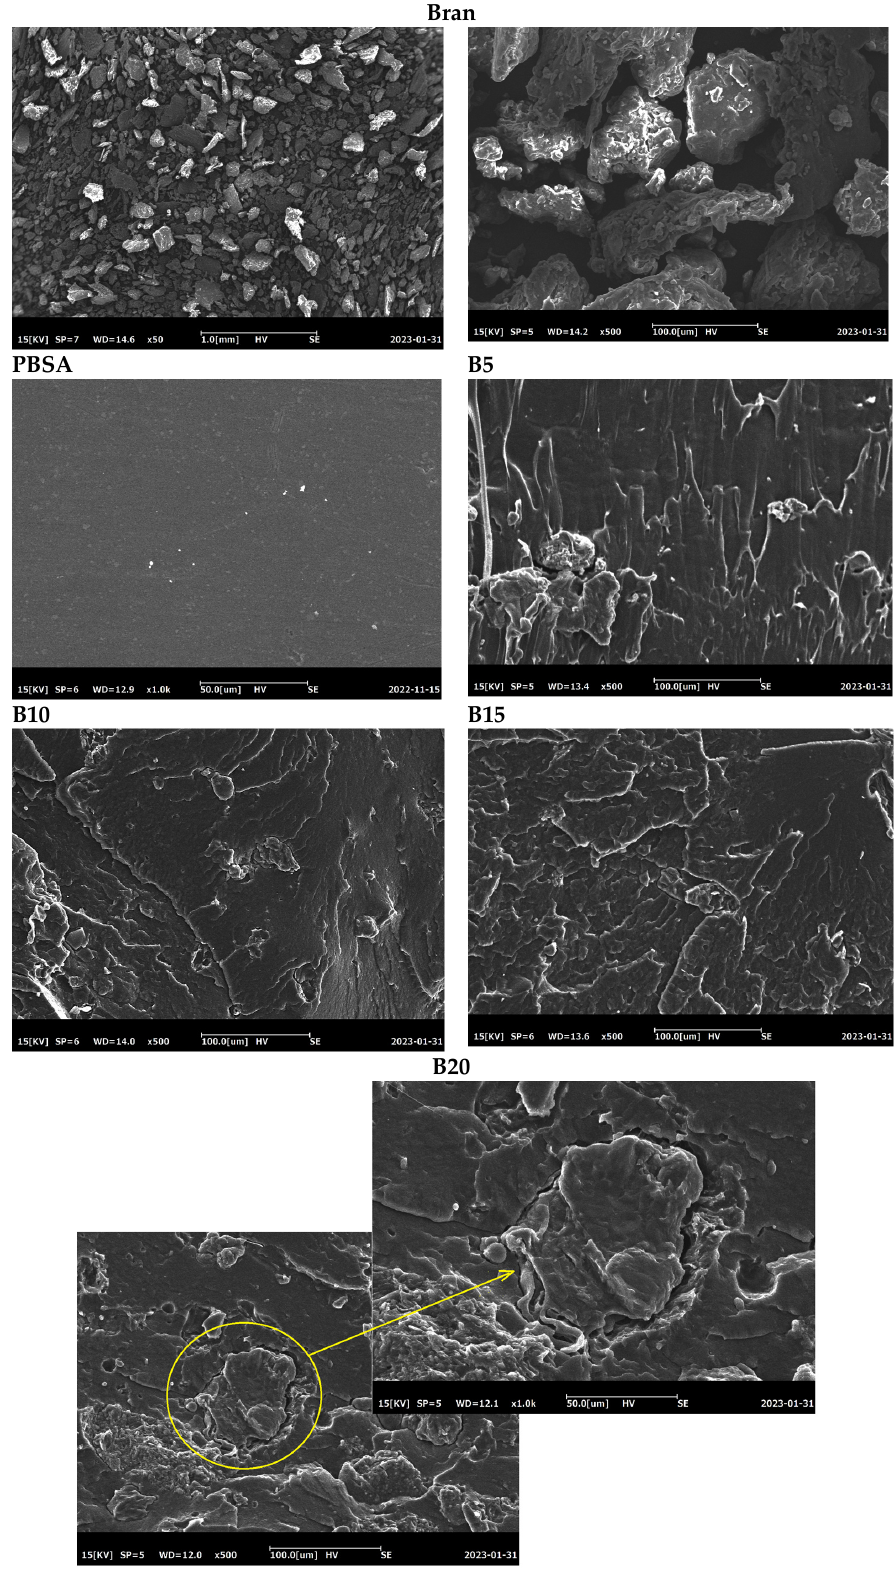
Figure 9. SEM images of bran and the freeze fractured surfaces of the PBSA and PBSA/B composite pellets. Poor particle/matrix adhesion is highlighted in the circle for the B20